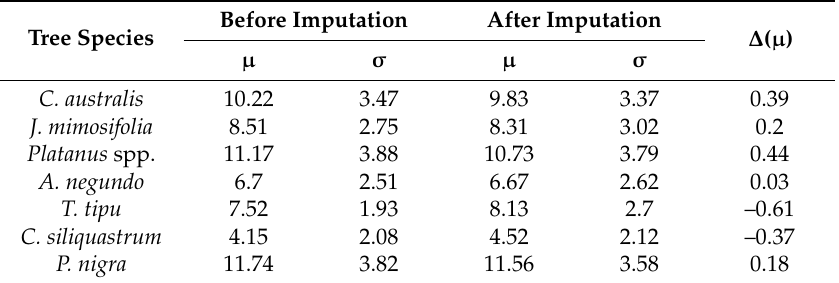
Table 6. Mean ( µ ) and standard deviation ( σ ) for ht (m) before and after imputation of missing values, along with the difference between before and after imputation